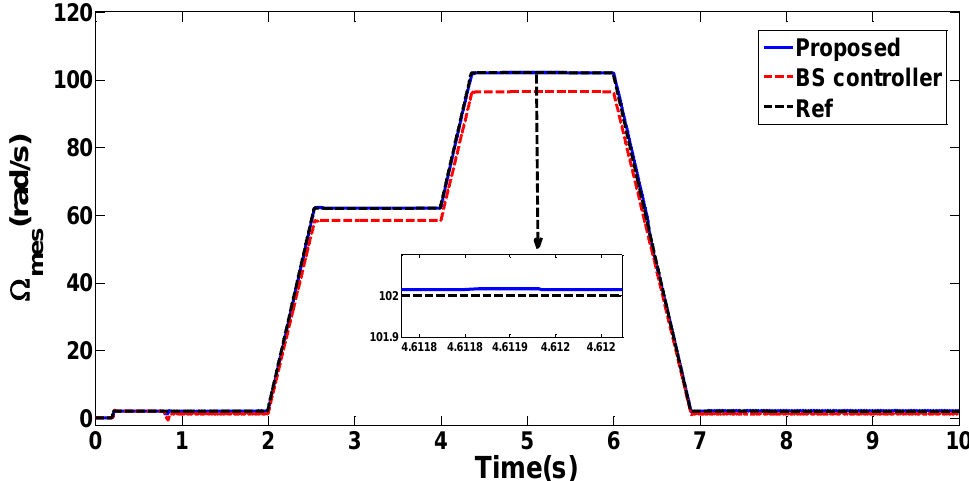
Figure 2. Velocity responses of the induction machine using BSC and IBS-DISMC.